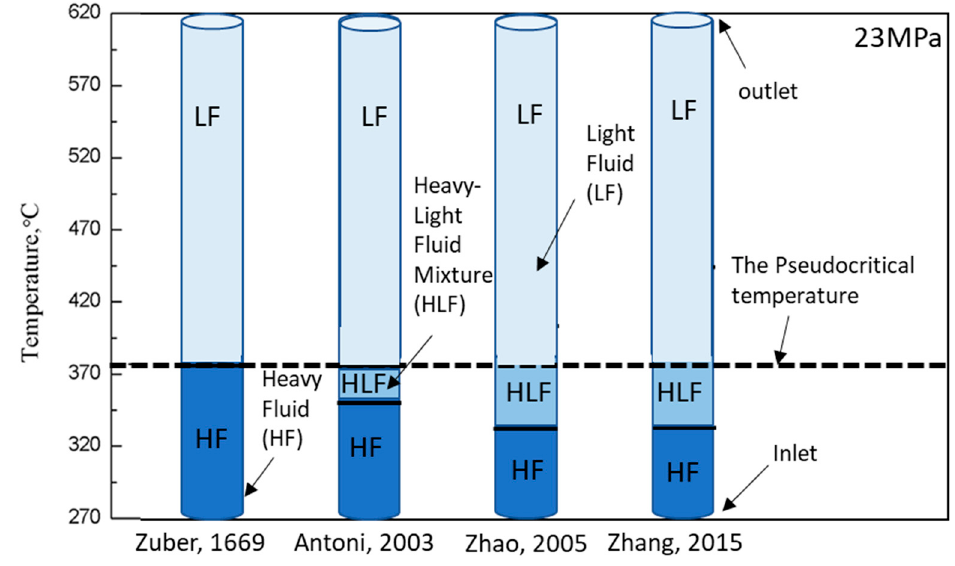
Figure 1. A systematic view of different nodalization approaches [9,23,25].